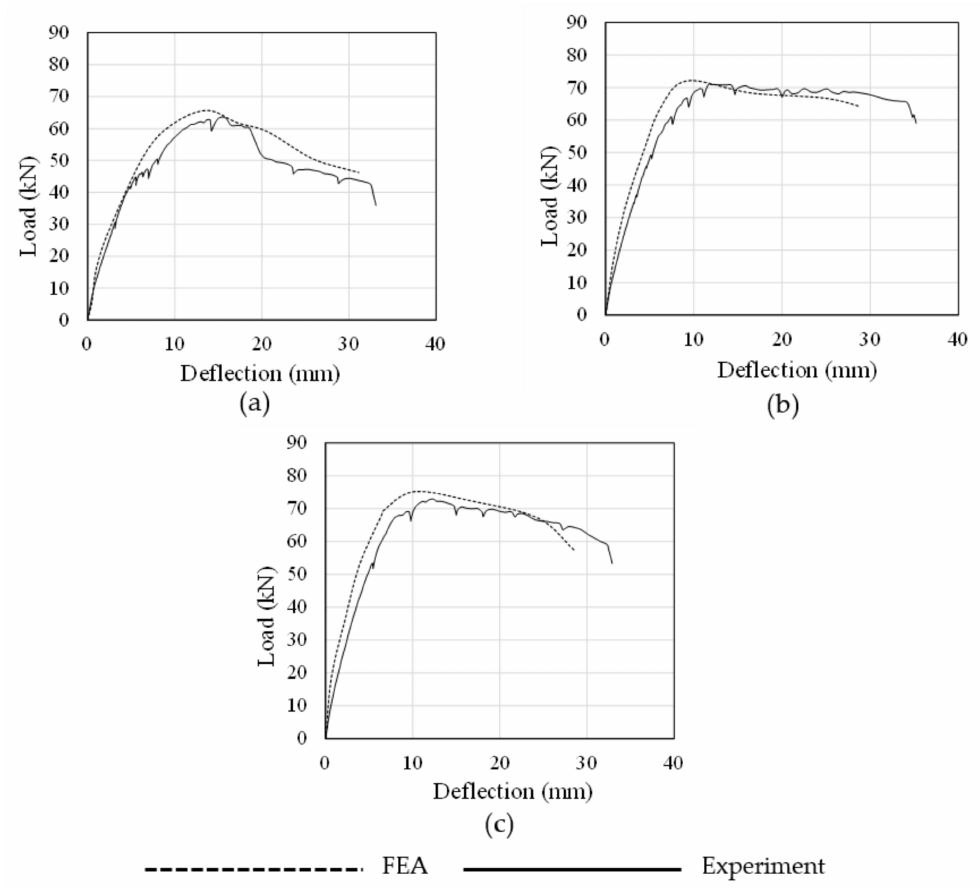
Figure 21. Load deflection curves of control and cotton FRRP composite strengthened beams ( a ) B-C-A, ( b ) B-C-B, ( c )